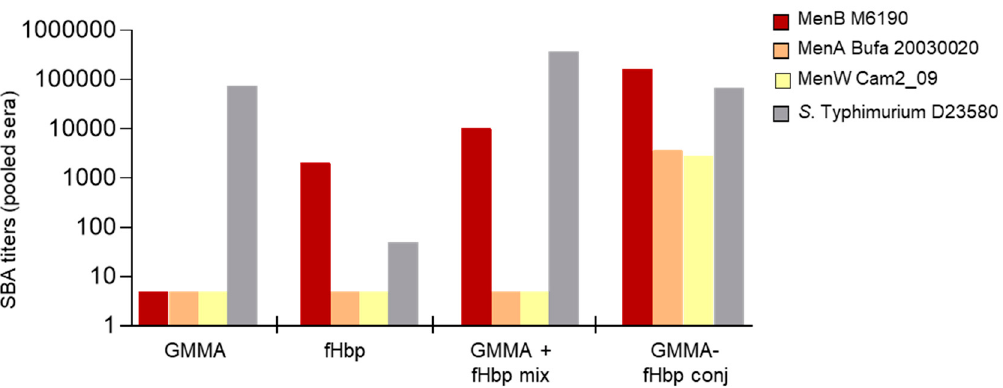
Figure 2. GMMA as a carrier for protein antigens: functionality of the antibody response. Eight CD1 mice per group were s.c. immunized at days 0 and 28, with S. Typhimurium GMMA conjugate of fHbp (0.75 µ g fHbp / dose). Protein antigen, GMMA alone or their physical mixture were used as controls. Formulations were tested with Alhydrogel. SBA titers of pooled sera collected at day 42 from each group against a panel of meningococcal strains and the S. Typhimurium strain are